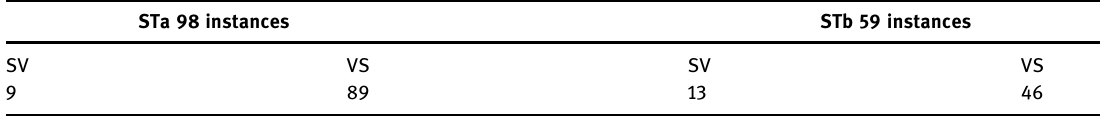
Table 5: Quotative inversion in ST